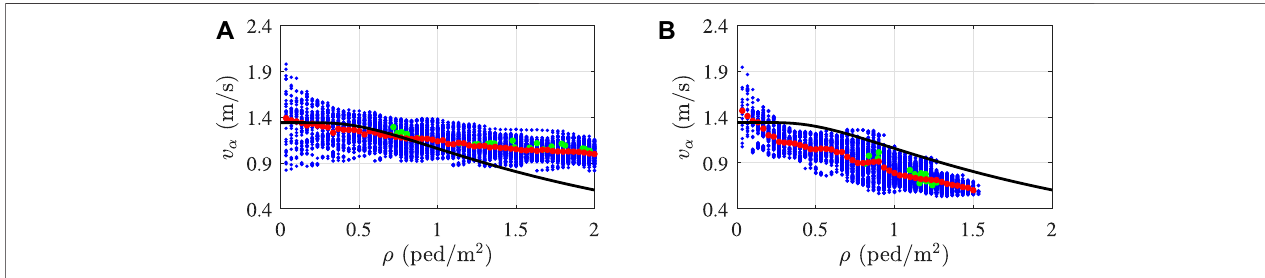
FIGURE7| Crowddensityandvelocityfromcriterion1(bluedots)andcriterion2(greendots)andsimulatedspeed-densityrelation(reddots)obtainedconsidering (A) A α , 1 (cid:2) 0.5 m/s 2 and (B) B α , 1 (cid:2) 1 m. Black curve: theoretical speed-density relation.